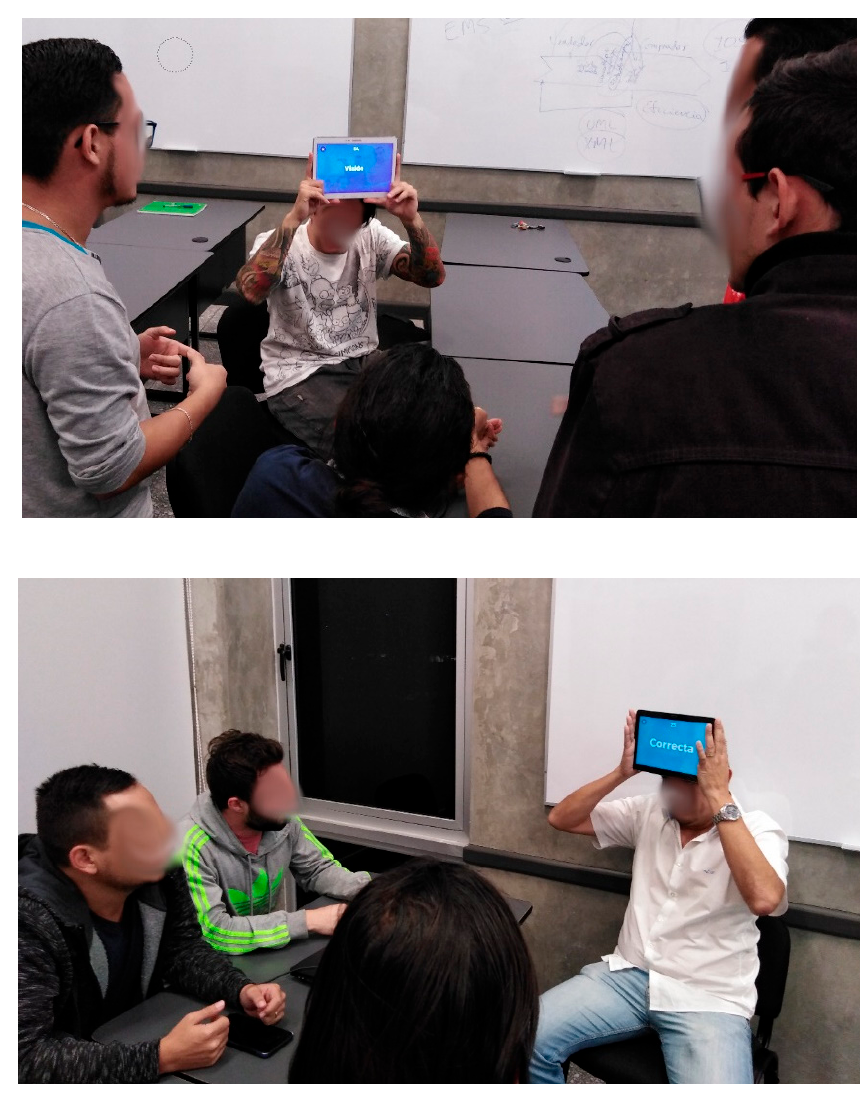
Figure 2. Agile HeadsUp